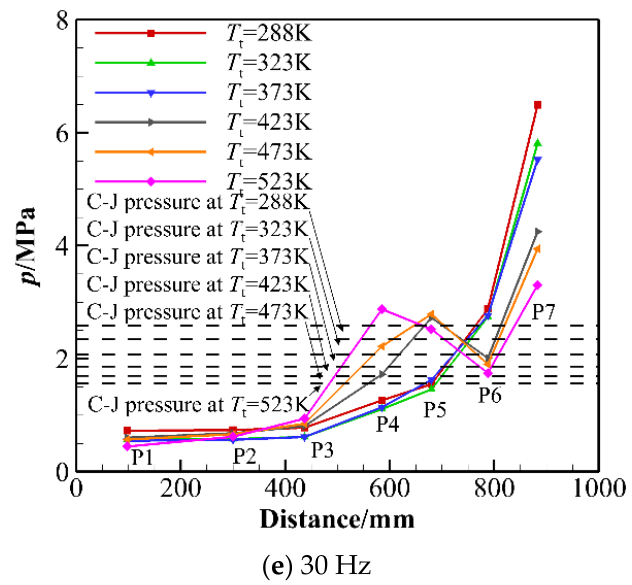
Figure 3. Average peak pressure under different working conditions.